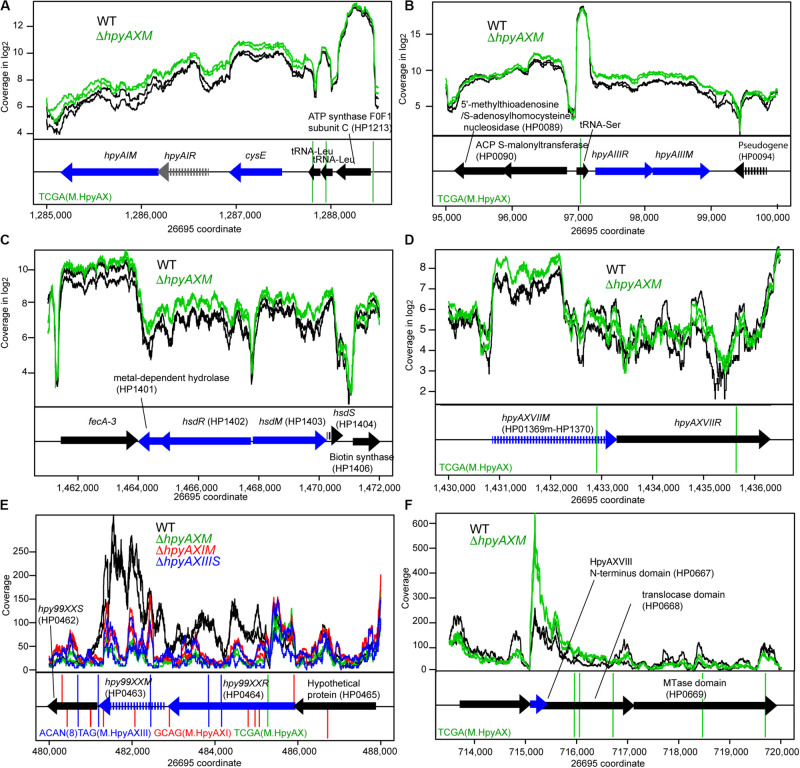
Effects of methyltransferase knockouts on transcript level of several methyltransferase loci. (A) HpyAI locus. (B) HpyAIII locus. (C) HP1403 locus. (D) HpyAXVII locus. (E) Hpy99XX homolog locus. (F) HpyAXVIII locus. The parental strain is 26695. Except for (E,F), read coverage is shown in logarithmic scale. A blue arrow indicates a differentially expressed gene. A vertical line indicates a copy of methylation motif. A broken arrow indicates a pseudogene. The transcripts are from both strands as RNA-seq for strain 26695 was carried-out in “non-stranded” protocol.